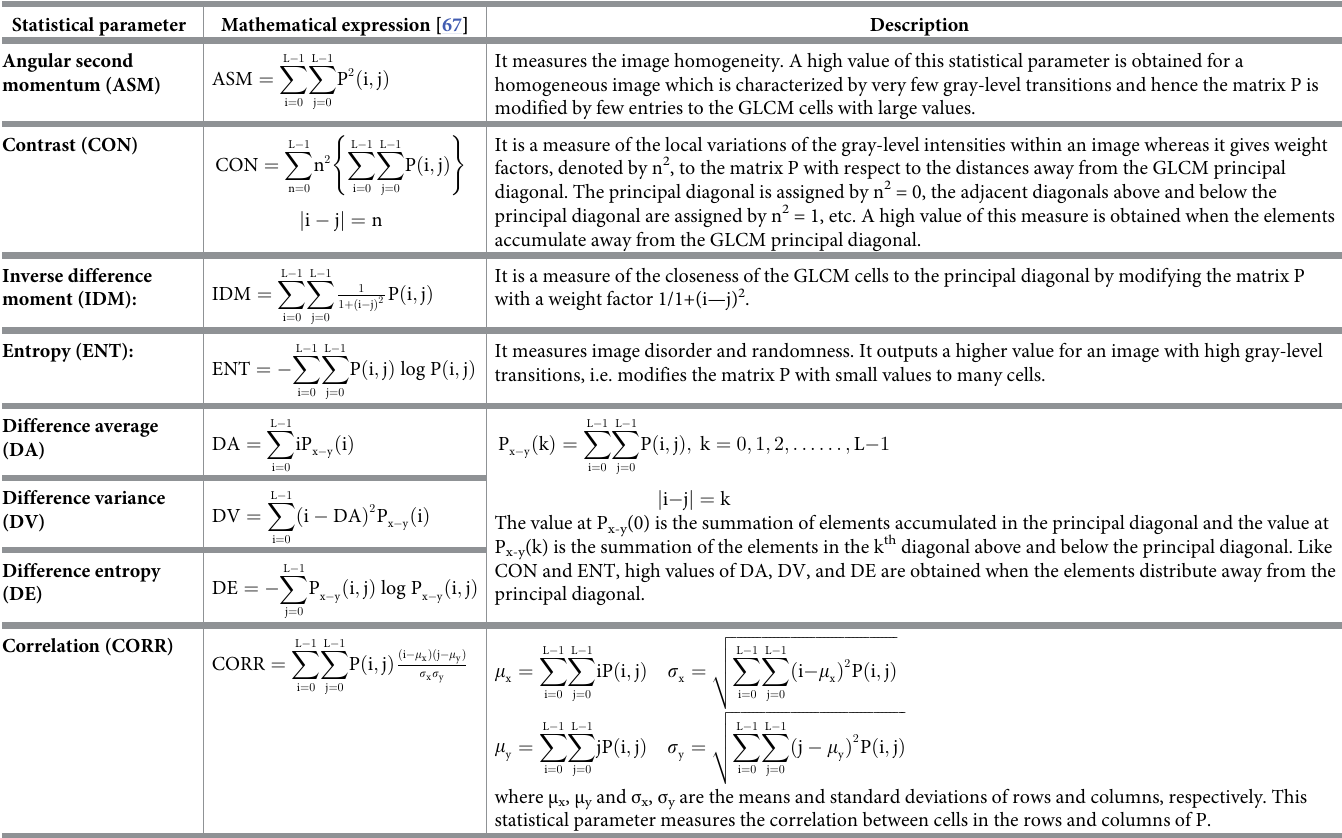
Table 1. Representation and description of Haralick’s statistical parameters. Statistical parameter Mathematical expression [67]